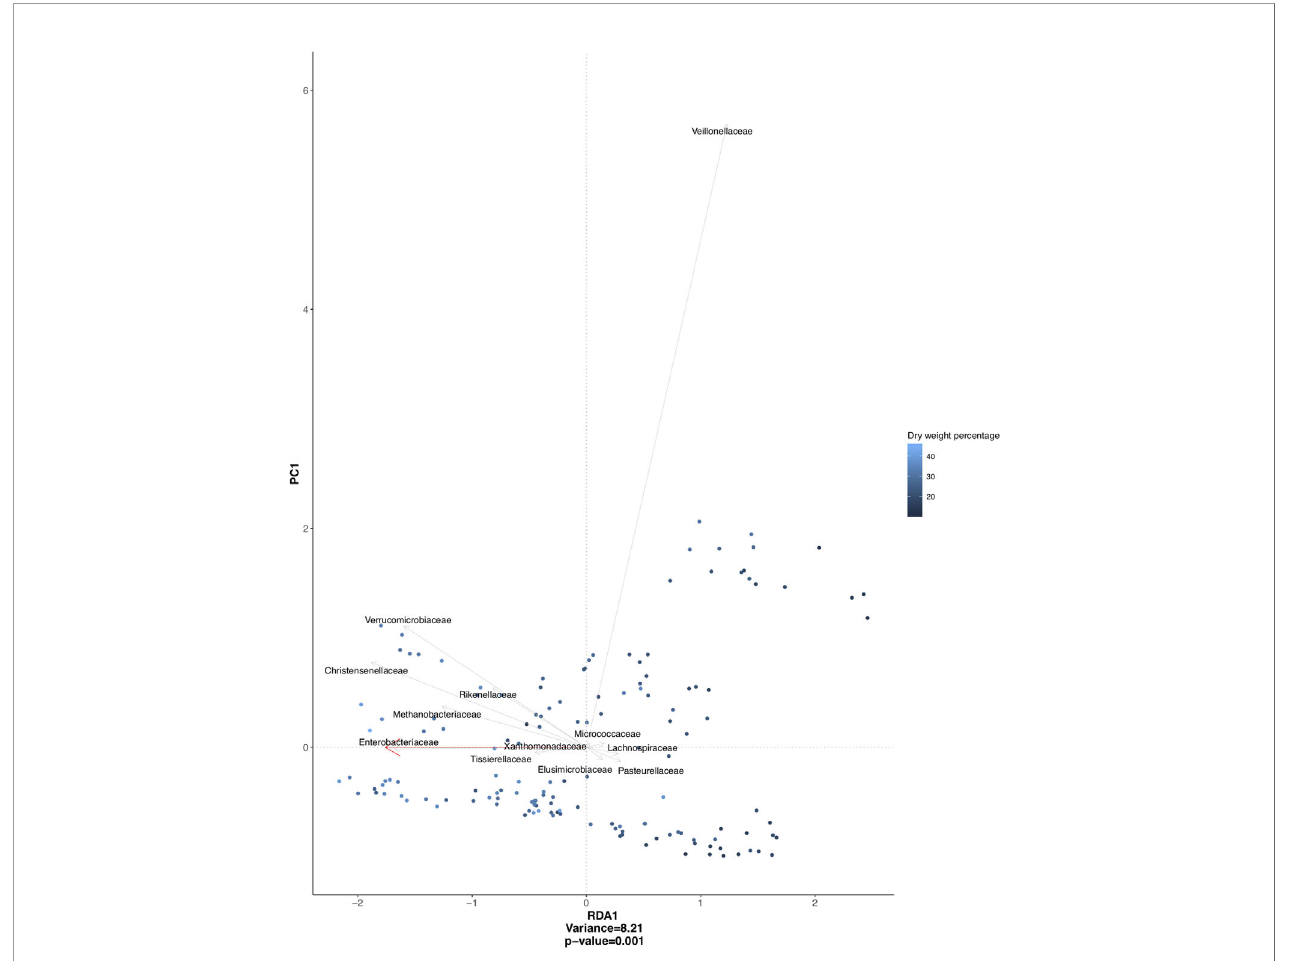
FIGURE 2 | Redundancy analysis plot based on clr transformed abundancies, and constrained on stool consistency (dry weight percentage), with individual variation partialled-out. Signi fi cant association between stool consistency and microbial composition (p = 0.001), mainly driven by bacterial families depicted in the fi